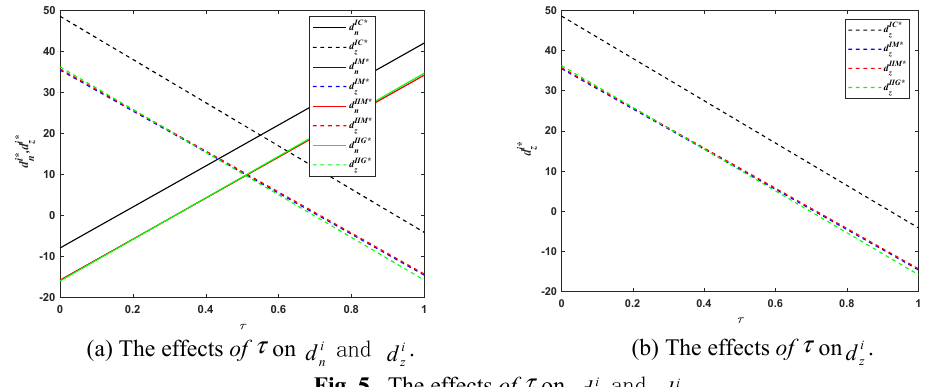
Fig. 5. The effects of τ